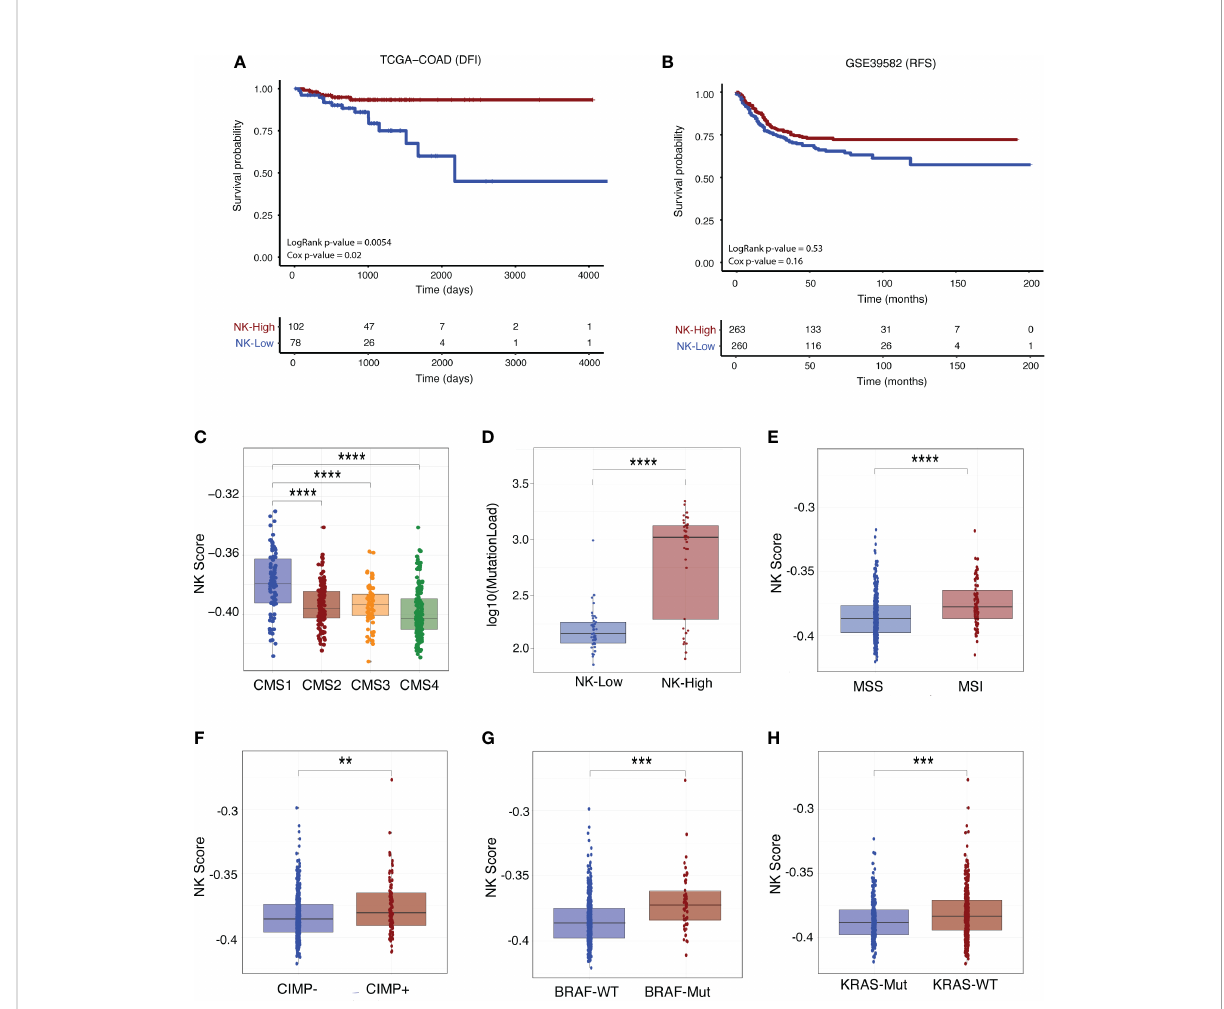
FIGURE 7 NK score is associated with survival outcome and other clinical parameters. Kaplan-Meier survival curves for patients strati fi ed by NK score (where “ NK-High ” and “ NK-Low ” are de fi ned as samples above and below the median NK score, respectively) for Stage I-III CRC patients in the (A) TCGA-COAD (DFI) and (B) GSE39582 (RFS) cohorts. Survival differences were tested using both log-rank and multivariate Cox proportional hazards models (adjusted for age, tumour stage and MMR status) with corresponding p-values indicated. (C) Boxplots of association of NK score with CMS status and (D) mutational load in TCGA-COAD patients. (E) Boxplots of association of NK score with MSI (F) CIMP (G) BRAF and (H) KRAS status in GSE39582 patients. (Student ’ s T-test; **p-value < 0.01; ***p-value < 0.001; ****p < 0.0001). DFI, disease-free interval; RFS, recurrence-free survival, MMR, mismatch repair; CIMP, CpG island methylator